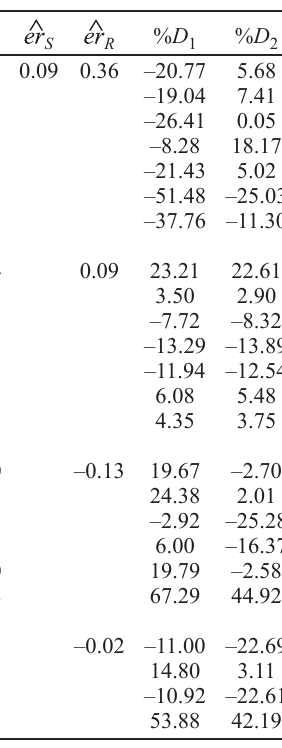
Table 5. Comparison of the accuracy of forecasted